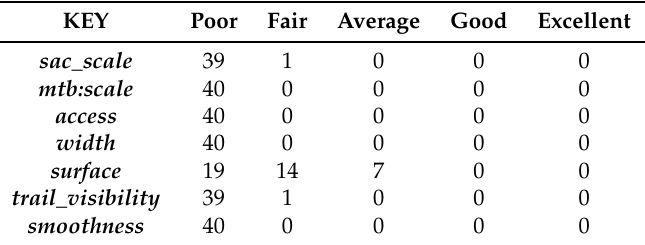
Table 7. Summary of compliance of all cities with suggested tag key combinations for the target tag highway=path .